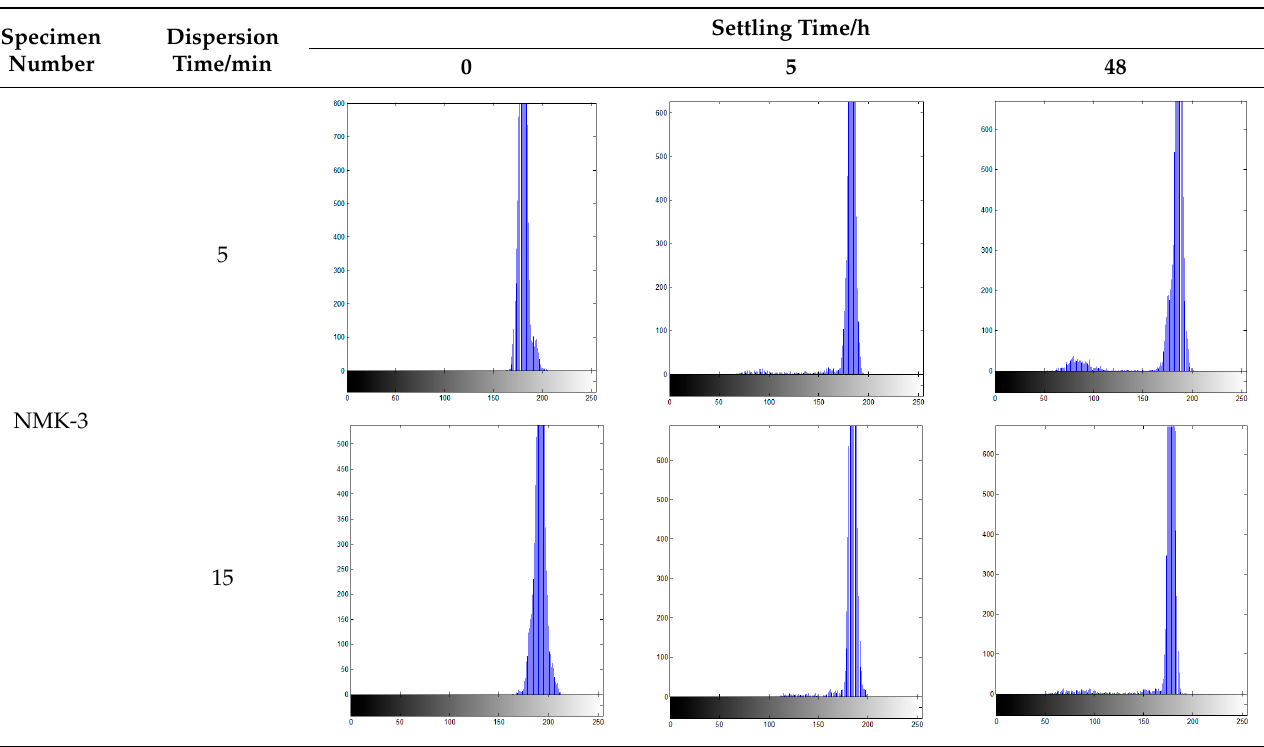
The relationship between the expected k , variance f , gray value change rate, and